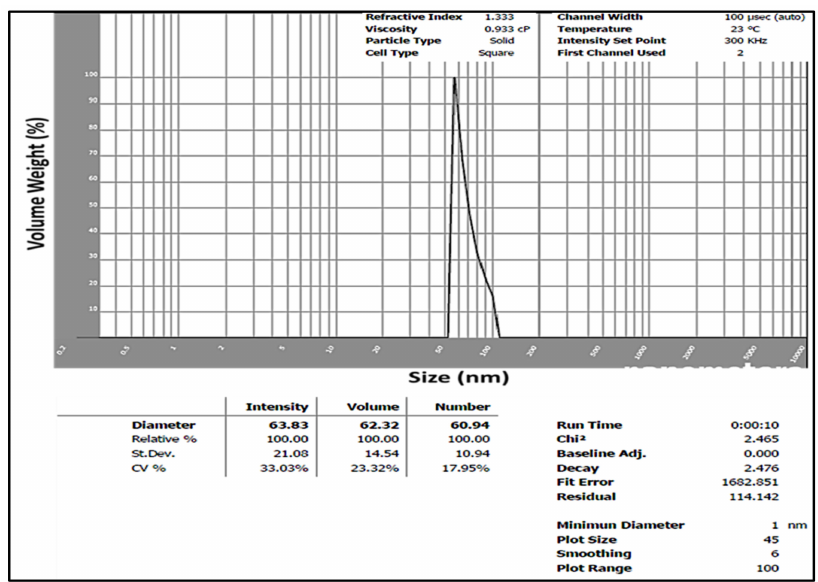
Figure 9. Particle size distribution of ZnO NPs measured by